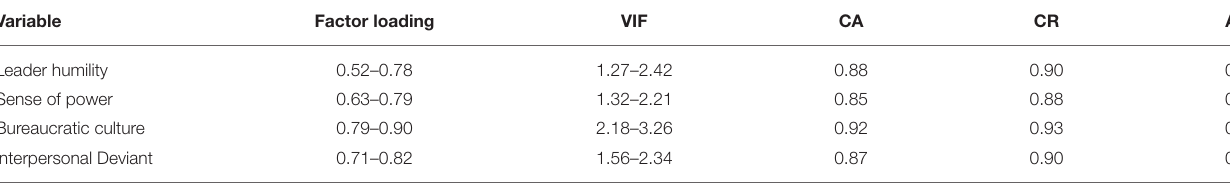
TABLE 1 | Scale items and evaluation of the measurement model. Variable